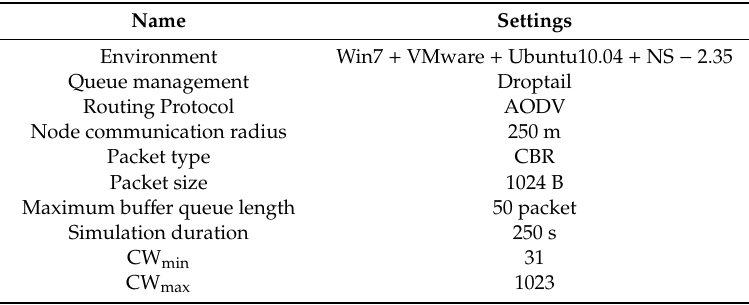
Table 2. Parameter